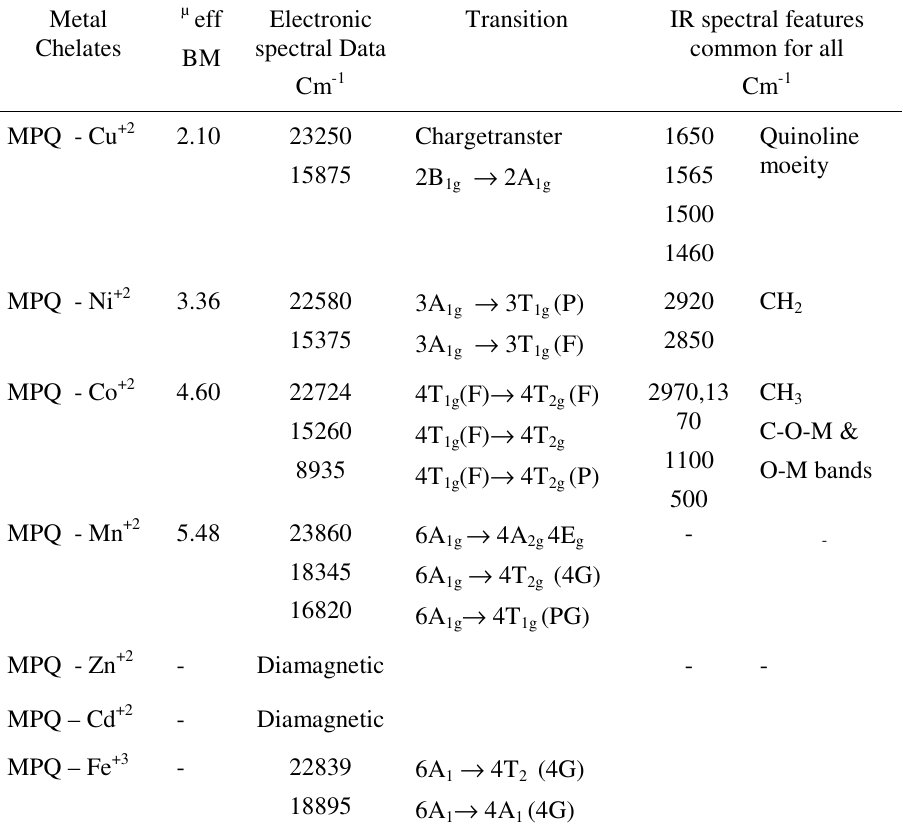
Table 2. Spectral Features and Magnetic Moment of MPQ – Metal